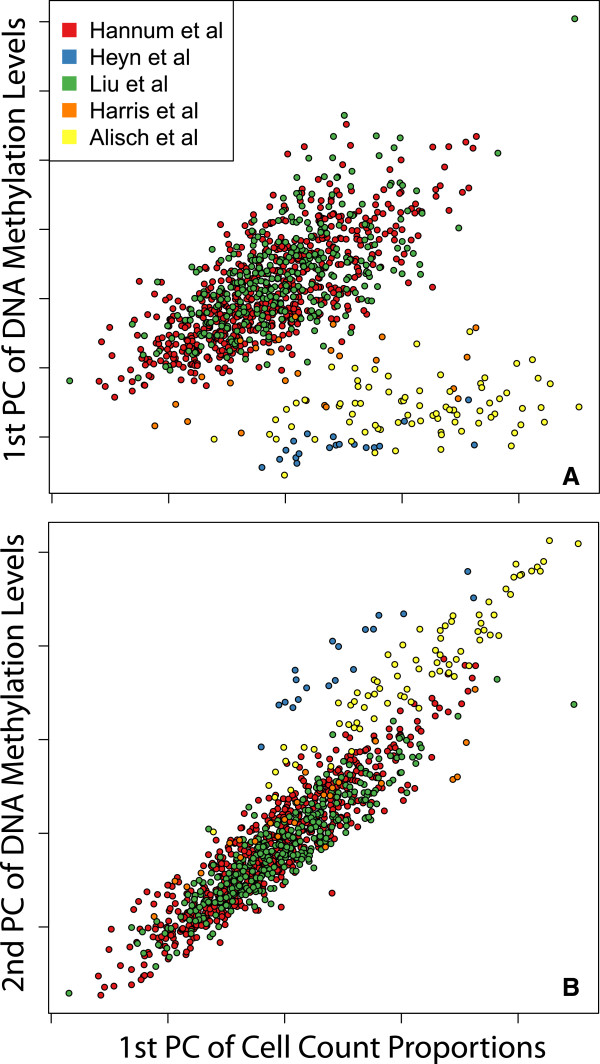
Cellular composition is a major source of variability in DNAm datasets in whole blood. Principal components (PCs) (A) 1 and (B) 2 of the 456,655 DNAm probes (y-axis) and the first PC of the empirical cell counts (x-axis) are highly correlated. The first PC of the DNAm data explains 10.9% of the variance, and the second explains 9.3% of the variance. Color indicates data source, which are described in Additional file 1.